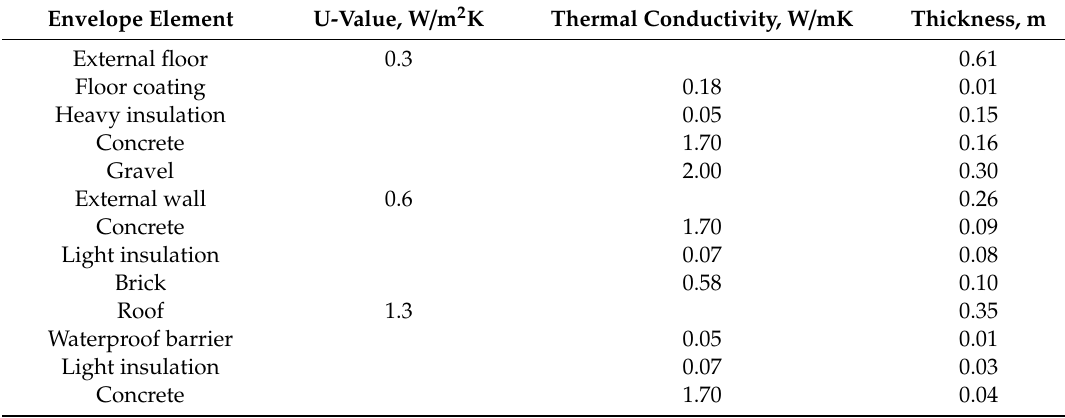
Table A2. Characteristics of the opaque components used in the simulation